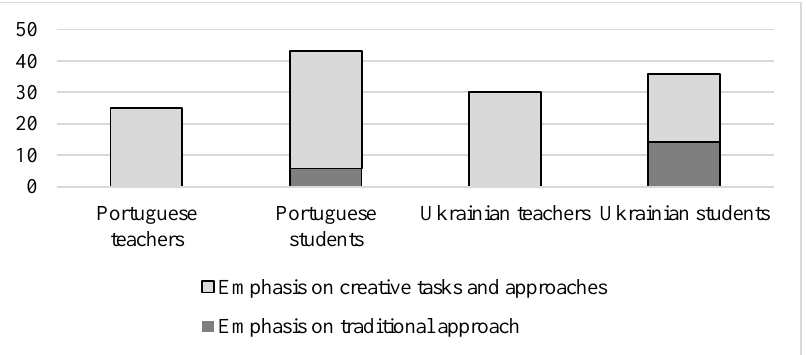
Fig. 7. Comparison of choices regarding English